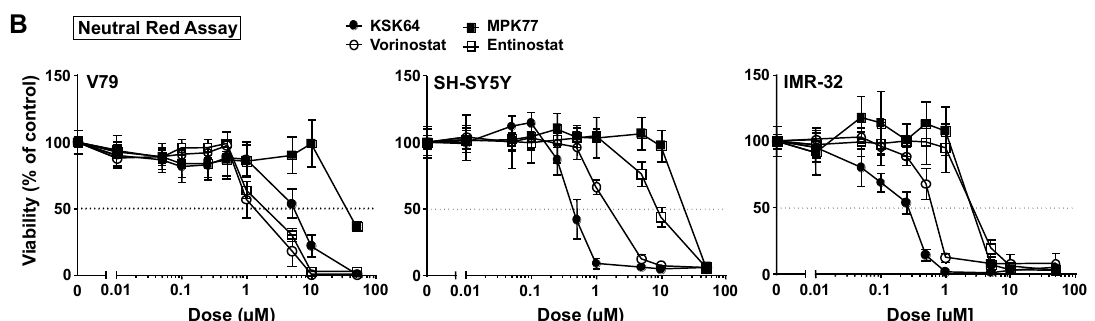
Figure 1. Comparative analysis of the cytotoxicity of novel hydroxamic acid- and benzamide-type histone deacetylase inhibitors (HDACi). Cell viability was analyzed 72 h after administration of representative HDACi candidate compounds (i.e., hydroxamic acid-type HDACi: KSK64, vorinostat; benzamide-type HDACi: MPK77, entinostat) using the Alamar blue and the Neutral red assay. The neuroblastoma cell lines IMR-32 and SY-SY5Y were used as a tumor cell model, whereas V79 lung hamster cells were employed as non-malignant counterpart according to the international OECD (Organisation for Economic Co-operation and Development) guidelines for toxicity testings. ( A ) Cell viability was measured by the Alamar blue assay. Data shown are the mean ± SD from n ≥ 2 independent experiments each performed in quadruplicate (N = 4). ( B ) Cell viability measured by the Neutral red assay. Data shown are the mean ± SD from n ≥ 2 independent experiments each performed in quadruplicate (N =